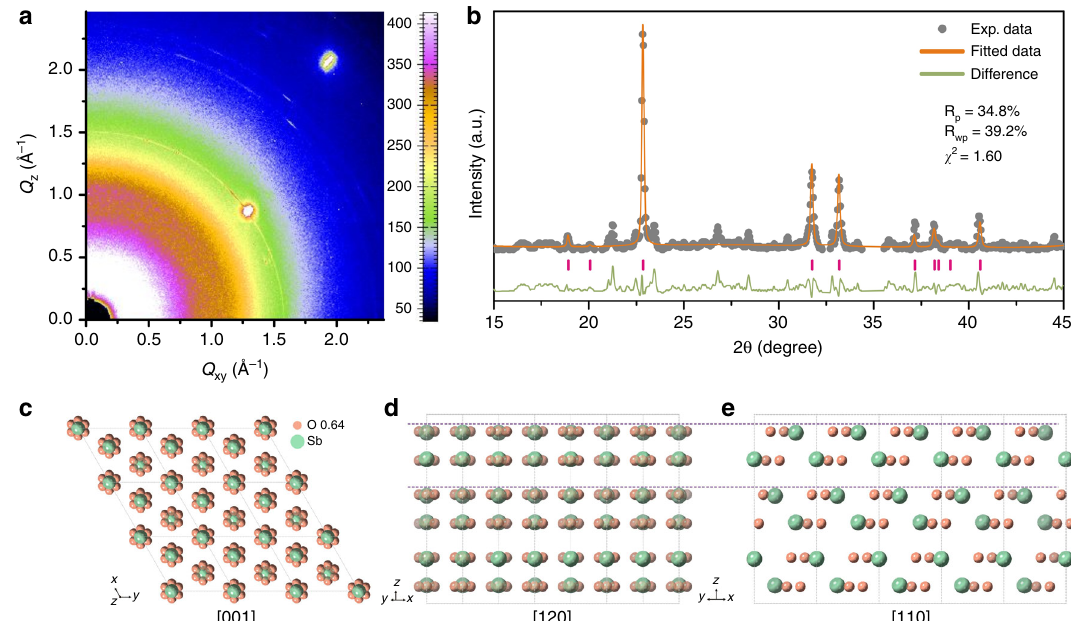
Fig. 2 Structure elucidation of ultrathin antimony oxide. a Synchrotron-based GI-XRD image of ultrathin antimony oxide. b The fi tting of GI-XRD data. c – e Schematic of the fi tted SbO 1.93 structure along the [001] ( c ), [120] ( d ), and [110] ( e ) directions.